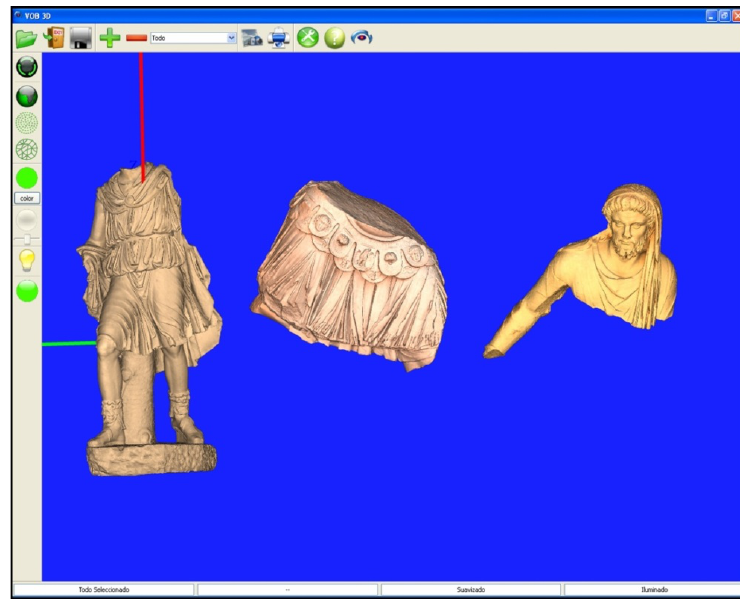
Figure 17. Screen-capture of the interactive